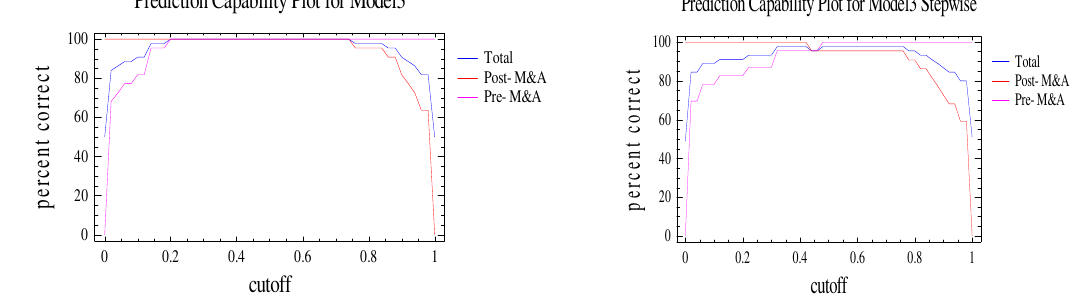
Fig. 3. Prediction capability plot using LR 3 (on the left-hand side) and LR 3 stepwise (on the right-hand side) for pre-post M&A